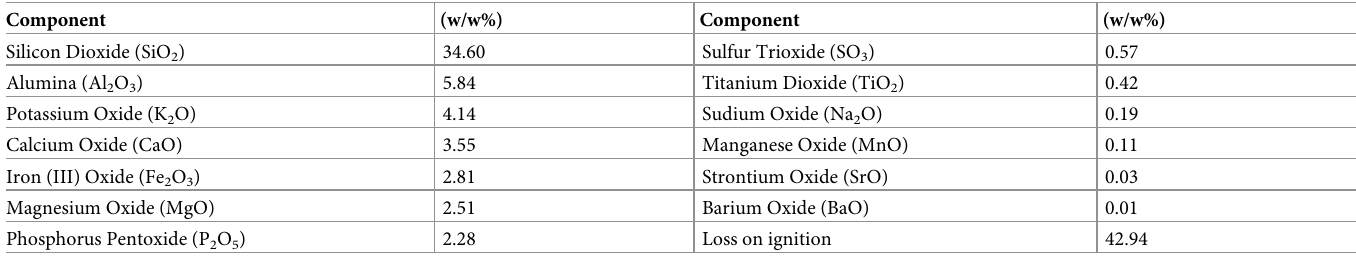
Table 2. Chemical composition of corn stover